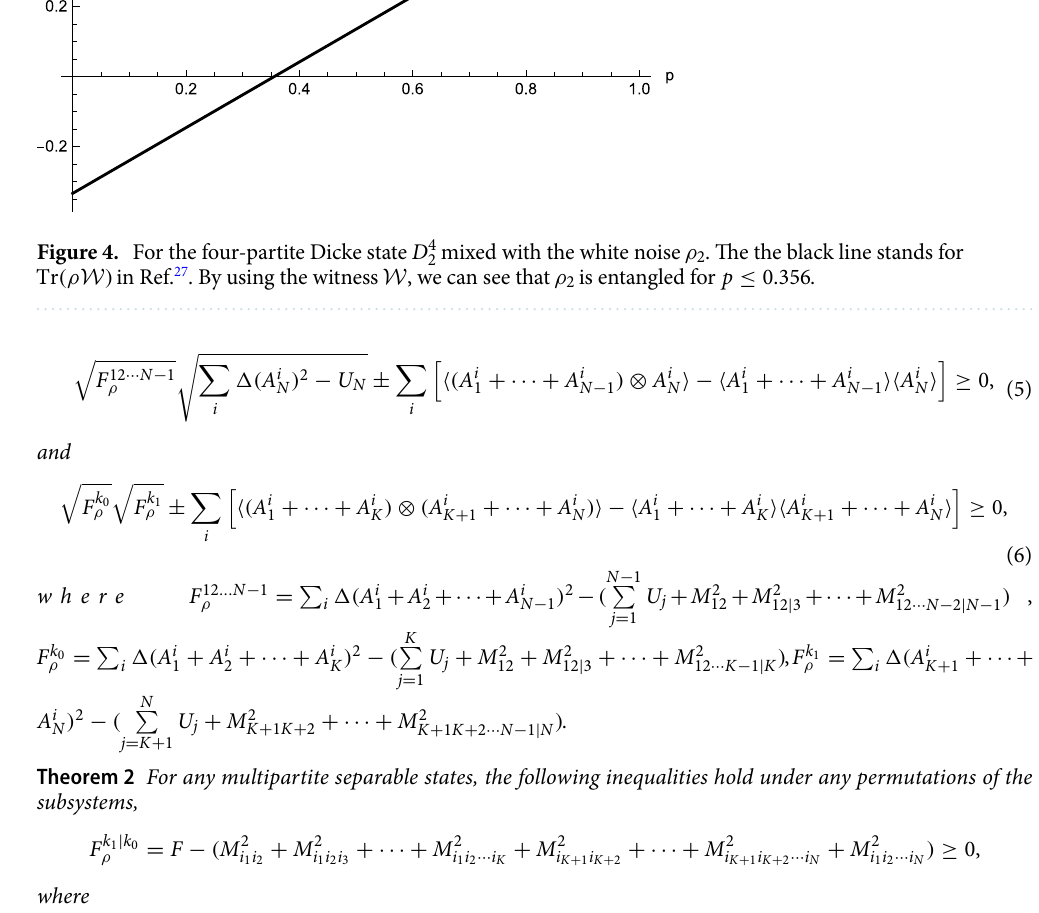
123 4 | ρ 2 and the red dash line stands for F